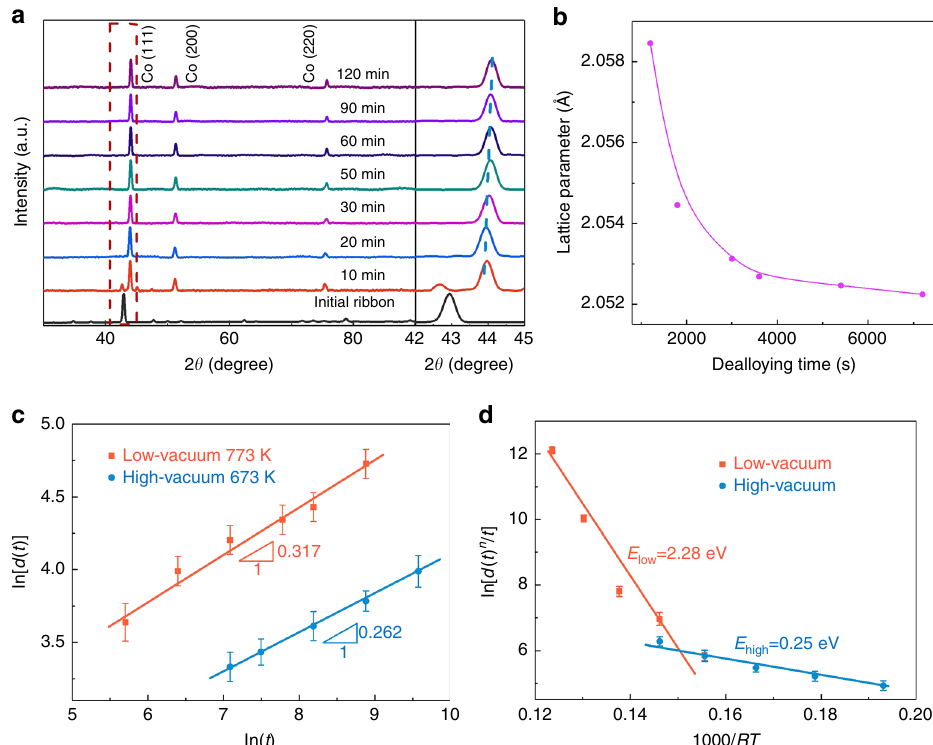
Fig. 4 Structure and physical properties of nanoporous cobalt. a XRD patterns of nanoporous cobalt prepared with various dealloying time at 773 K and 100 Pa. b Evolution of lattice parameter of nanoporous Co with different dealloying time at 773 K and 100 Pa. c Measurements of the coarsening exponents from the plots of ln[ d ( t )] vs ln( t ) for low- and high-vacuum dealloying conditions. d The estimated activation energies for the nanoporous cobalt formation and coarsening at different dealloying